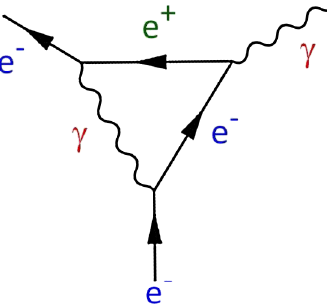
FIG. 5. Decomposition as an analog of the Feynman diagram.